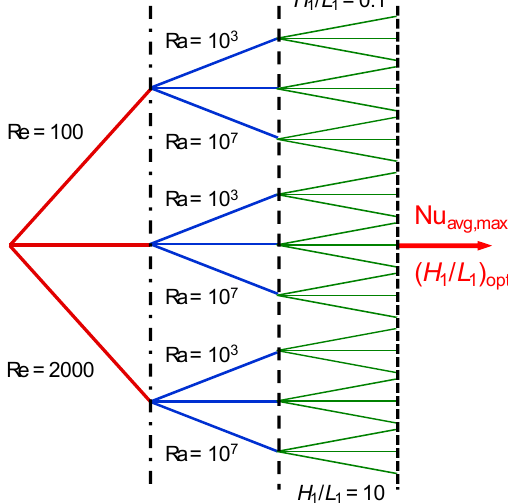
Figure 2. A flowchart illustrating the fin optimization process by using a combination of constructal design and exhaustive search. Here Nu avg,max is the average Nusselt number at an optimum fin aspect ratio of ( H 1 / L 1 ) opt .